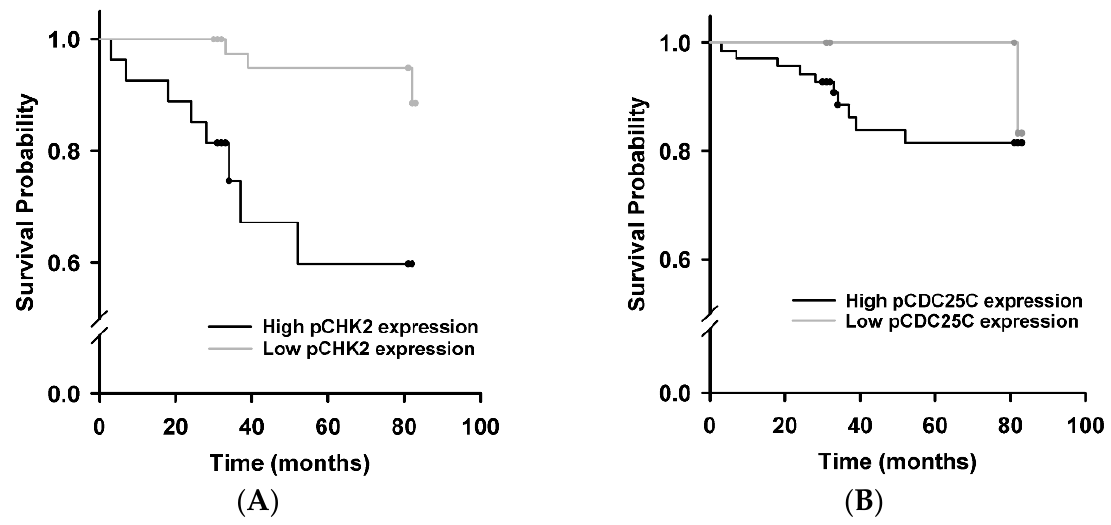
Figure 2. Survival curves using the Kaplan–Meier method: ( A ) Kaplan–Meier curve of overall survival in relation to pCHK2-Thr68 protein expression levels ( p < 0.001); and ( B ) Kaplan–Meier curve of overall survival in relation to pCDC25C-Ser216 protein expression levels ( p = 0.392).